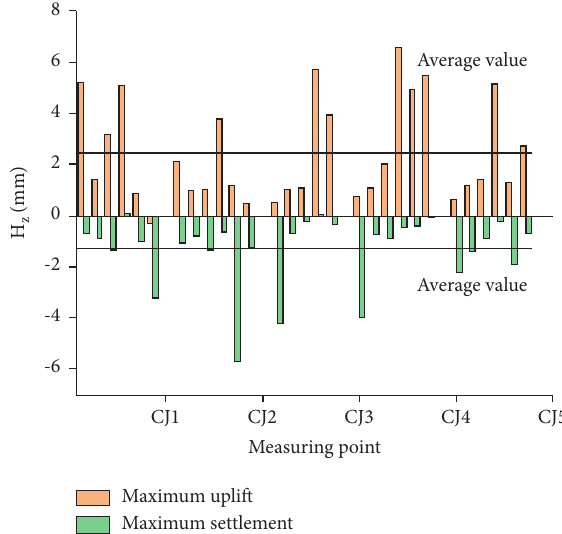
Figure 12: Histogram of the maximum uplift and settlement values outside the